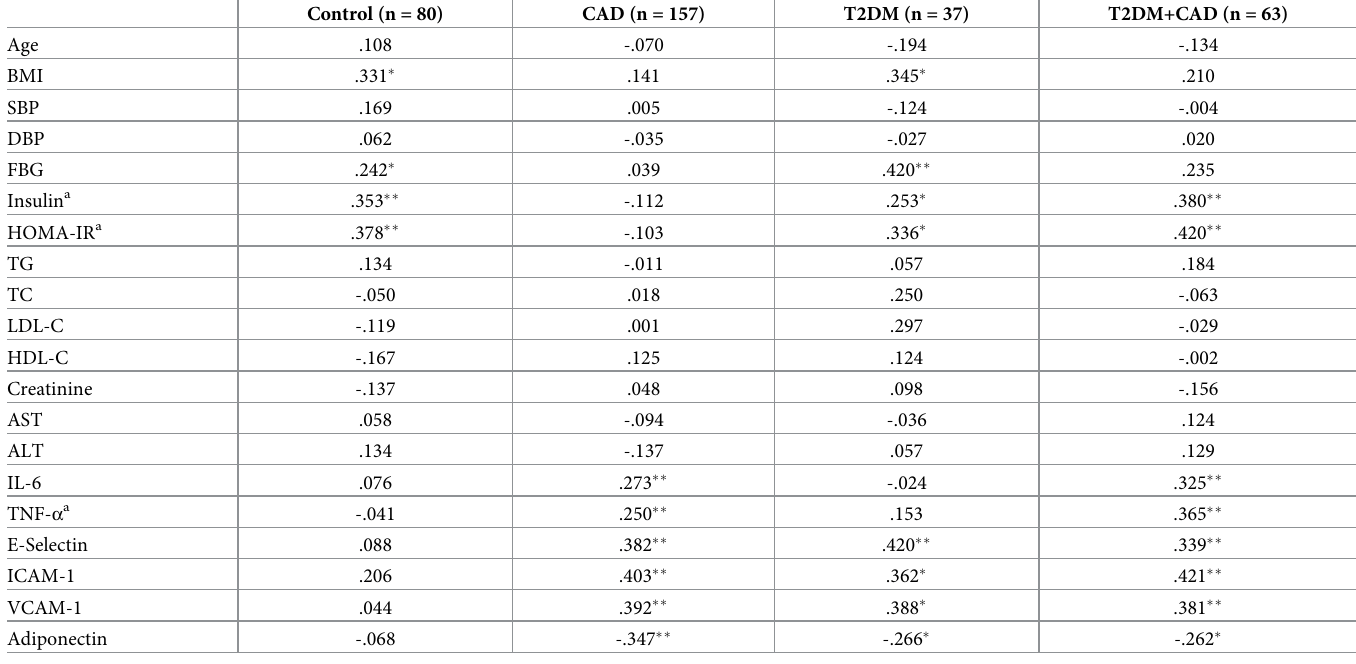
Table 3. Pearson correlation of CTRP9 with anthropometric and metabolic